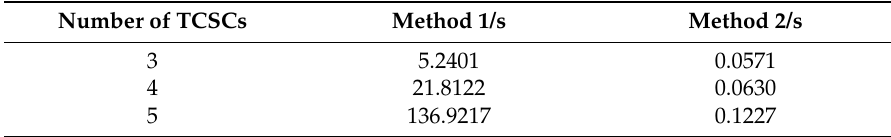
Table 6. Comparison of computing time with the change of TCSC